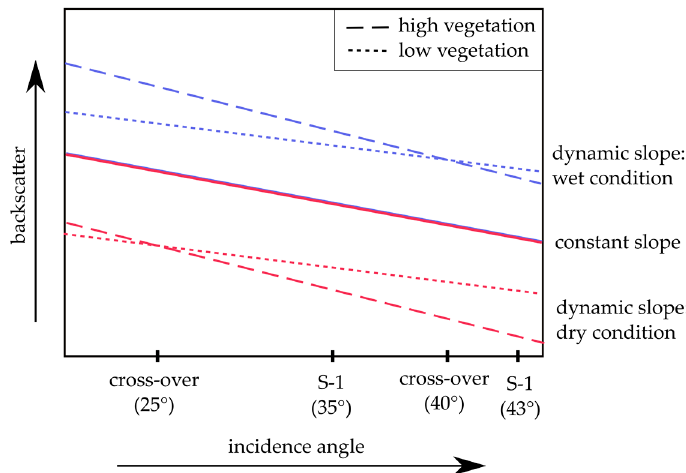
Figure 4. Schematic illustration of derived constant and dynamic slopes between backscatter and incidence angle (modified after [19]). Slope is influenced by vegetation biomass. Moisture shifts the absolute levels of backscatter. Dry and wet cross-over angles are set to 25° and 40°. Incidence angles of Sentinel-1 (S-1) over the study area are also indicated.